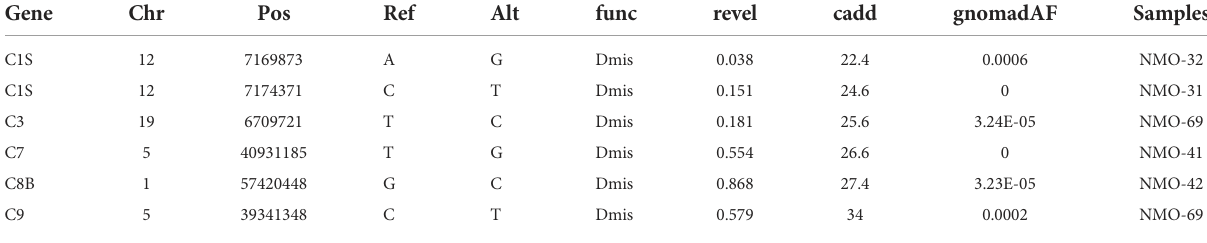
TABLE 3 List of damaging rare genetic variants identi fi ed by exome sequencing in the genes encoding proteins that are part of the complement